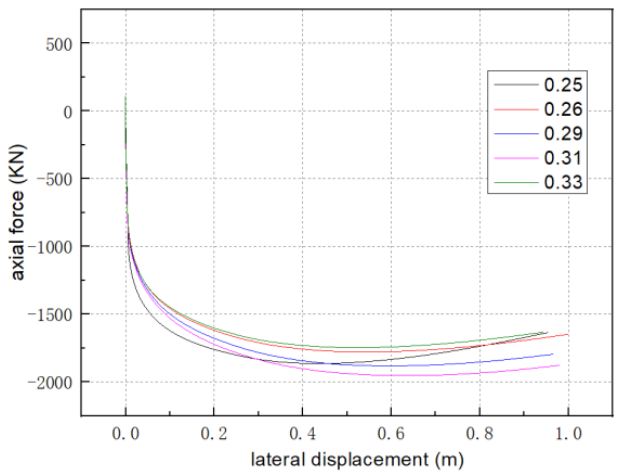
Figure 5. Influence of the buoyancy density in the axial force – lateral displacement graph. Table 3. Critical axial force of the buoyancy density. The Buoyancy